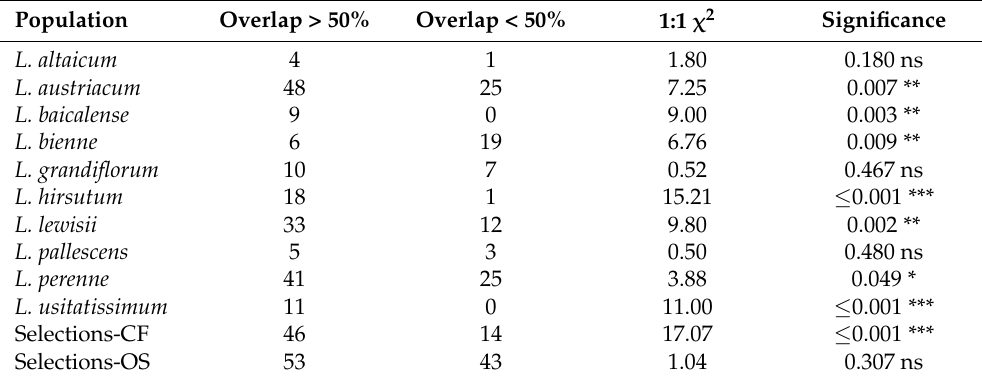
Table 3. 1:1 Chi-square tests (1:1 χ 2 test statistics, significance, df = 1) for petal overlap in flax species, CF and OS selection populations. For ornamental value in CF and HP genotypes, petal overlap > 50% (no gaps between petals) is desired to give the appearance of a larger, more full-looking corolla with “flower power”. Counts represent the number of individual plants within each category of petal